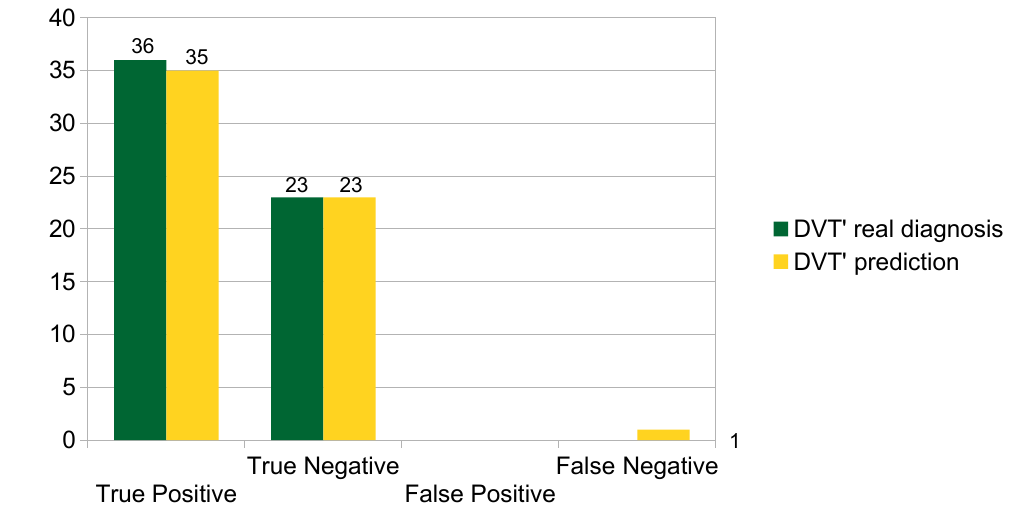
Figure 10. External validation of the proposed ANN model by using historical data from a Mexican